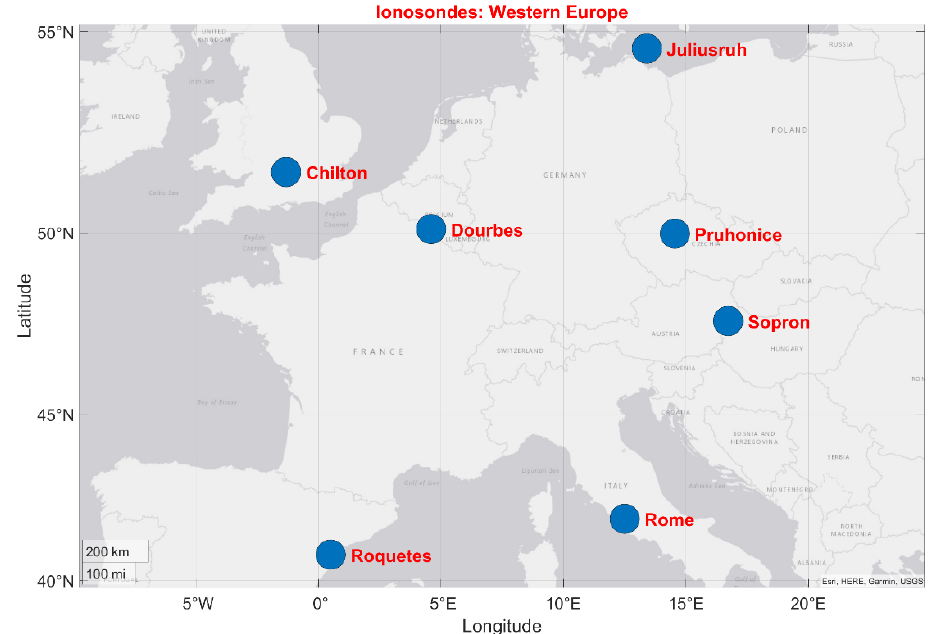
Figure 4. Continuously active ionosondes in Central and Western Europe.